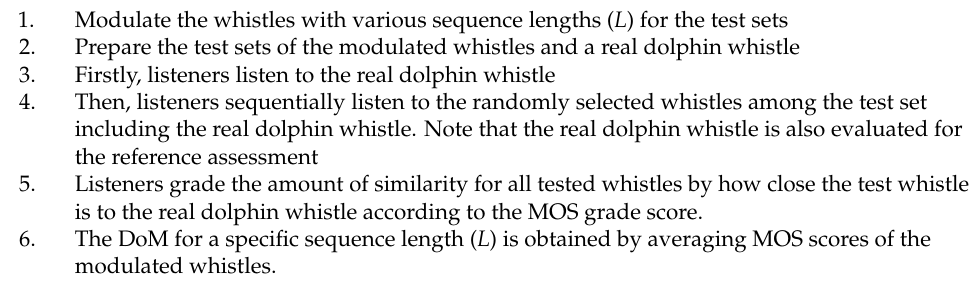
Table 1. The 1st step Degree of Mimic (DoM)